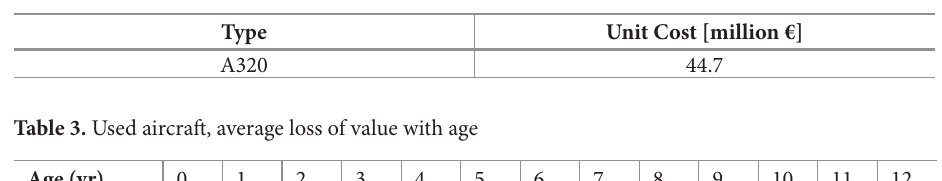
Table 2. Unit value of new aircraft (1999) based on average published list prices